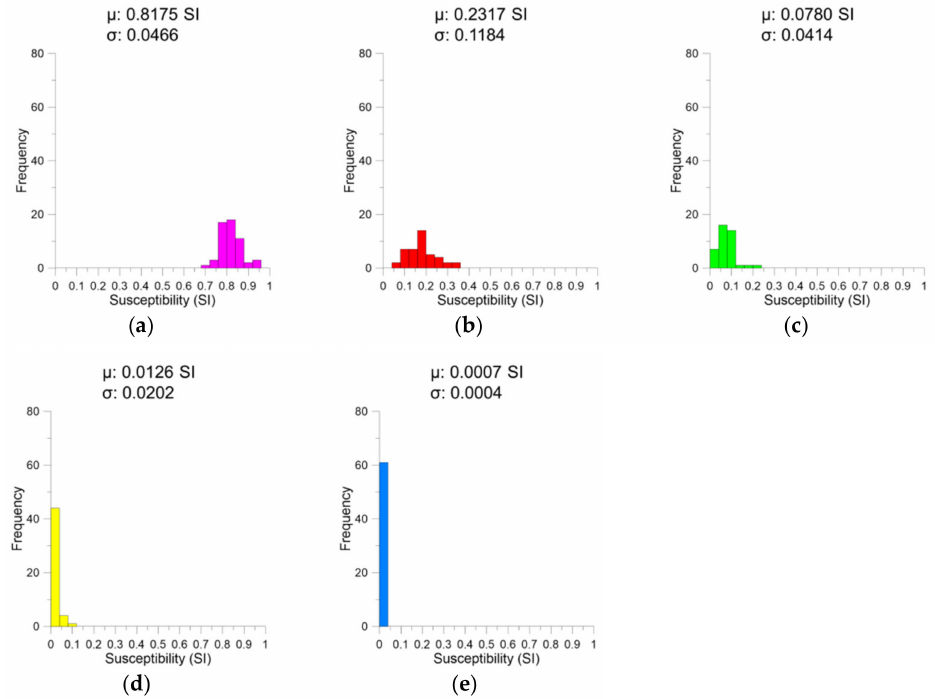
Figure 5. Histograms of susceptibility of rocks including mean ( µ ) and standard deviation ( σ ) of ( a ) underground ore, ( b ) discovered ore, ( c ) gabbro, ( d ) monzodiorite, and ( e ) quartz